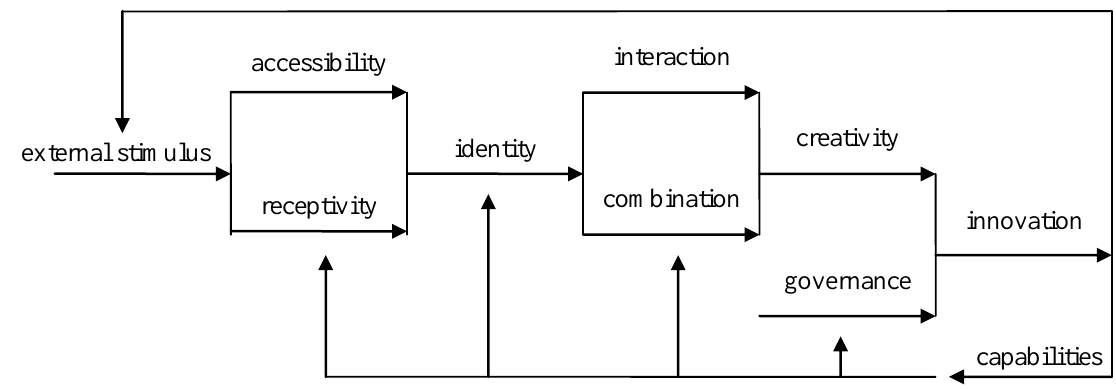
Figure 1: The Systemic/Cognitive Model of Knowledge